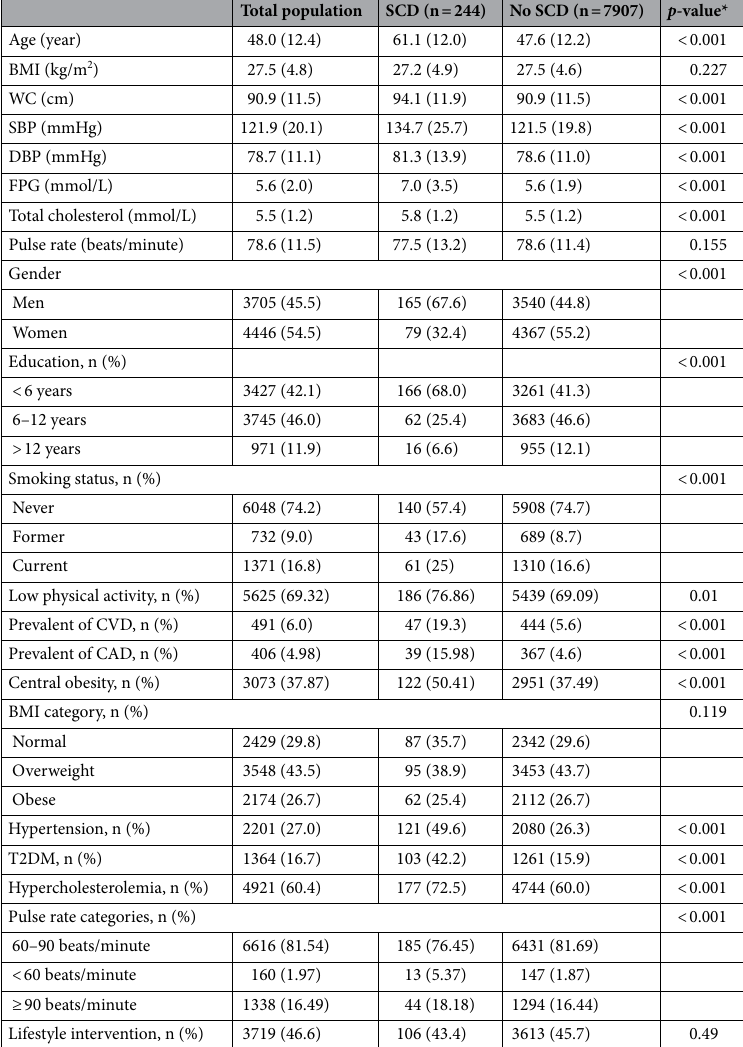
Table 1. Baseline characteristics of the population who experienced and didn’t experience SCD: Tehran Lipid and Glucose Study 1999–2016. SCD sudden cardiac death, BMI body mass index, WC waist circumference, SBP systolic blood pressure, DBP diastolic blood pressure, FPG fasting plasma glucose, CVD cardiovascular disease, CAD coronary artery disease, T2DM type 2 diabetes mellitus. Values are shown as Mean (SD) and number (%), for continuous and categorical variables, respectively. *P -values have been extracted from comparisons between the SCD and no SCD